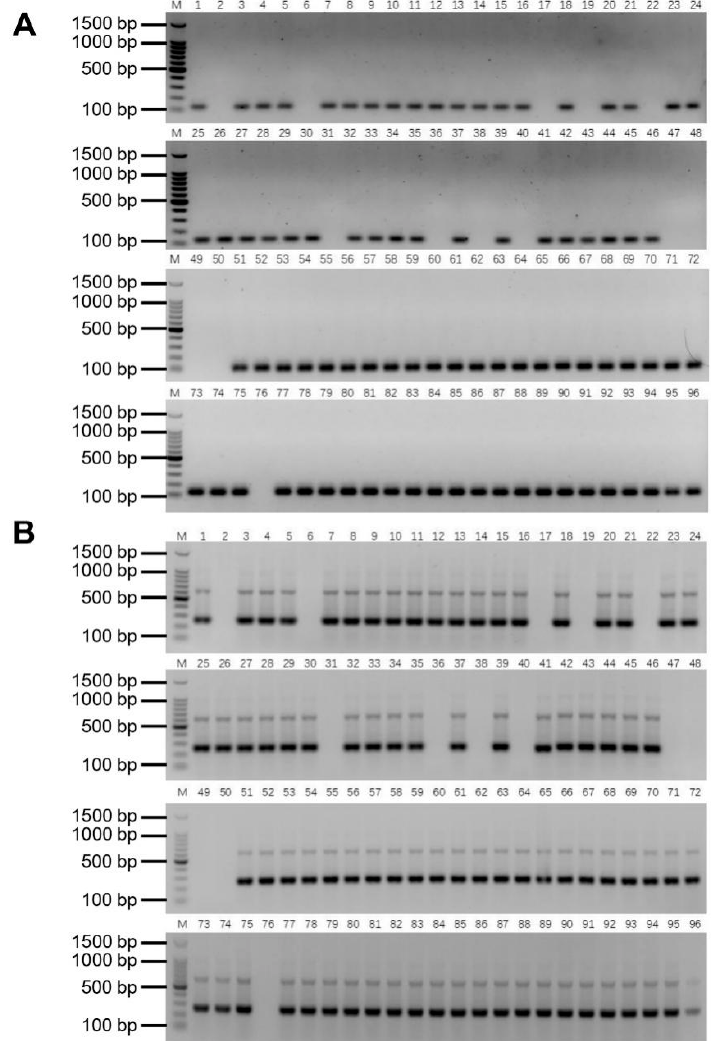
Figure 8. PCR detection result of putative BC 4 progeny between sugarcane and E. arundinaceus . ( A ) Ea086-128 primer; ( B ) Ea009-257 primer. M: 100 bp DNA Ladder; 1–24: Putative progeny between CP89-2143 and YCE06-61; 25–48: Putative progeny between CP94-1100 and YCE06-61; 49–72: Putative progeny between HoCP01-564 and YCE06-61; 73–96: Putative progeny between GT00-122 and YCE06-61.